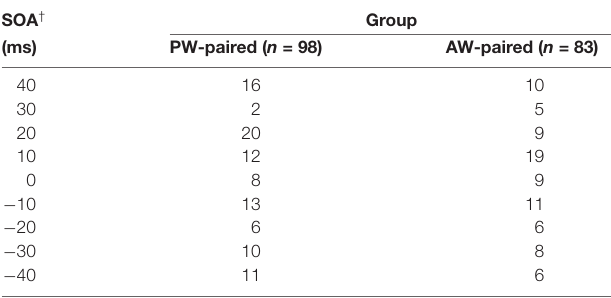
TABLE 2 | Number of single units in each pairing parameter combination: 9 SOAs × 2 paired whiskers. SOA † Group (ms) PW-paired ( n =